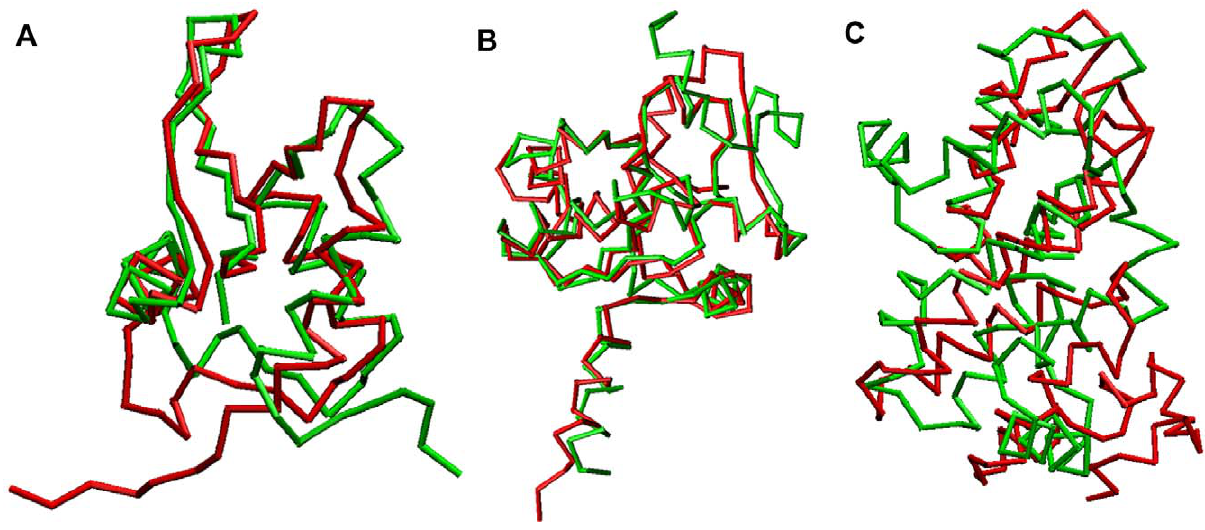
Figure 1. Modeled structures for three CASP9 targets, T0549, T0592 and T0553, by FR-t5. (a) The superposition between the native structure of T0549 (green) and the top1 model (red) predicted by FR-t5. (b) The superposition between the native structure of T0592 (green) and the top1 model (red) predicted by FR-t5. (c) The superposition between the native structure of T0553 (green) and the top1 model (red) generated by FR-t5.